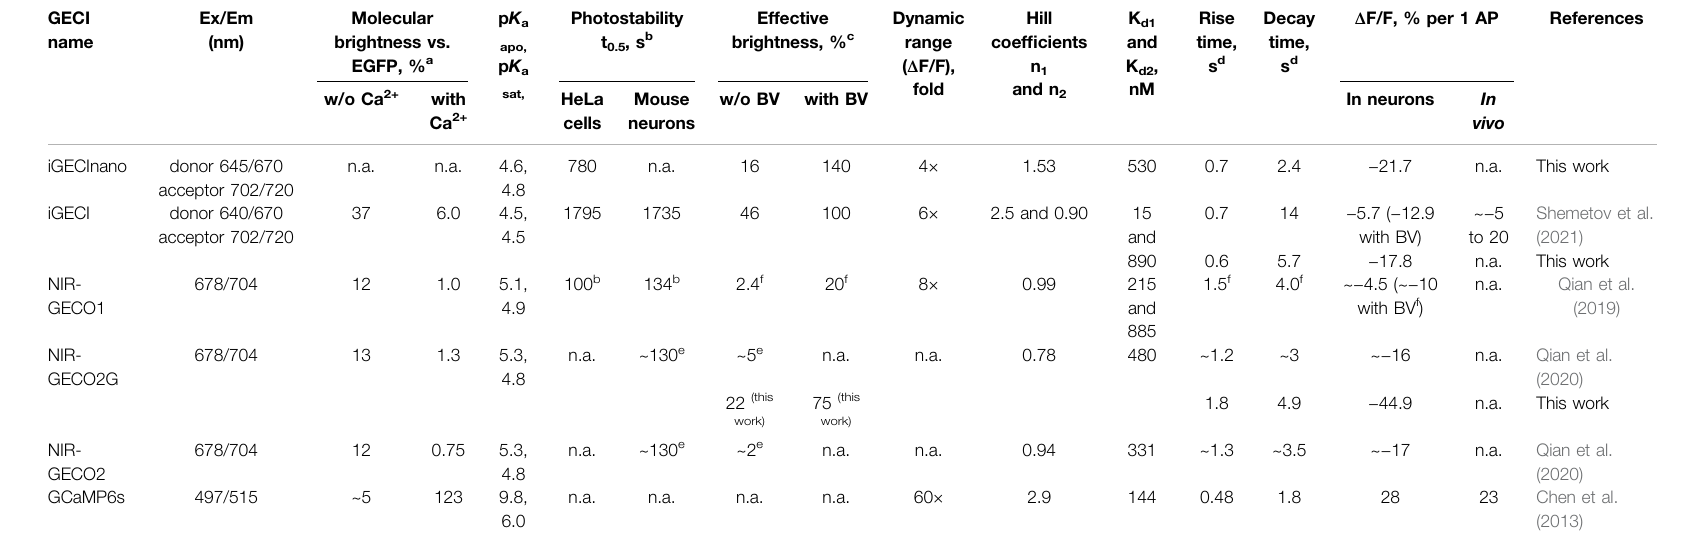
TABLE 1 | Comparison of iGECInano with other NIR GECIs and widely used GCaMP6s. GECI